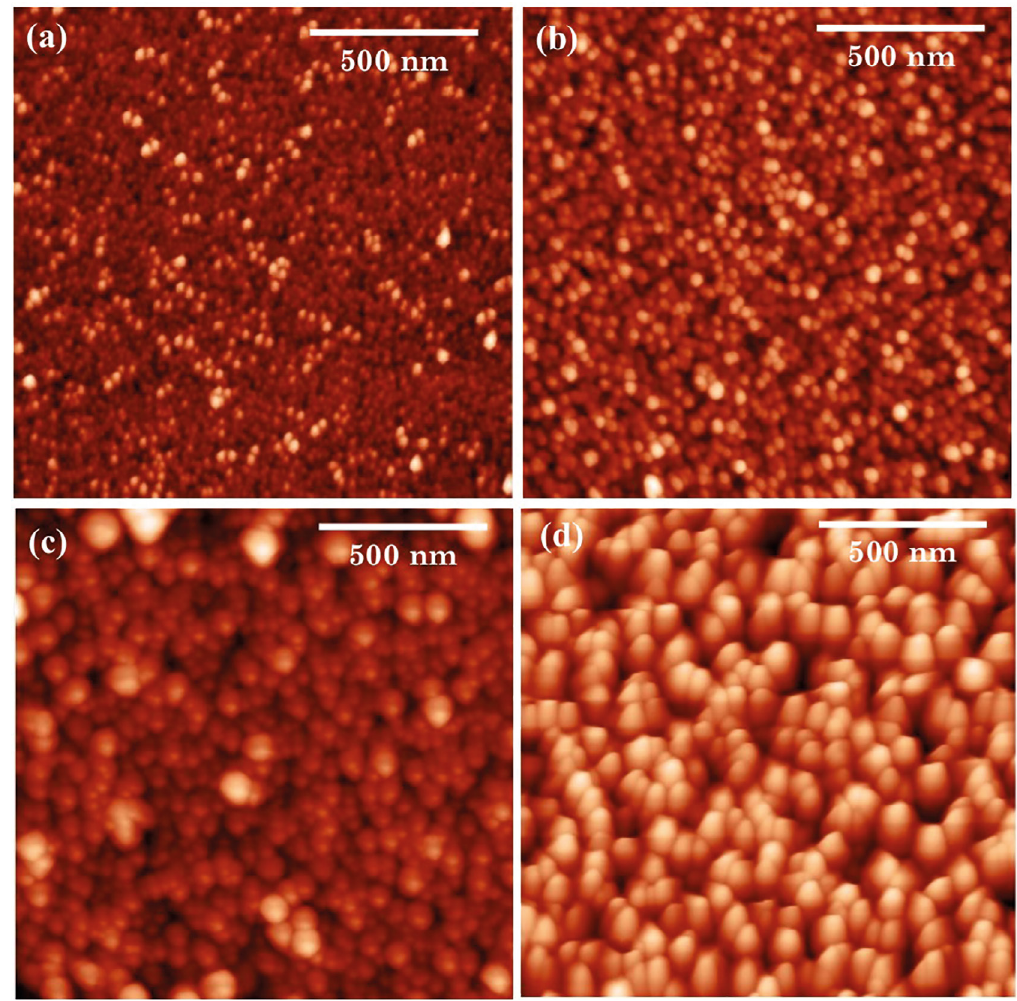
Figure 3. AFM microstructures of (a) t = 30 nm, (b) t = 90 nm, (c) t = 150 nm and (d) t = 220 nm CrN/Si (100) films. Table 1. Various parameters of different thicknesses of CrN/Si(100) films Thickness (t) of CrN/Si(100)